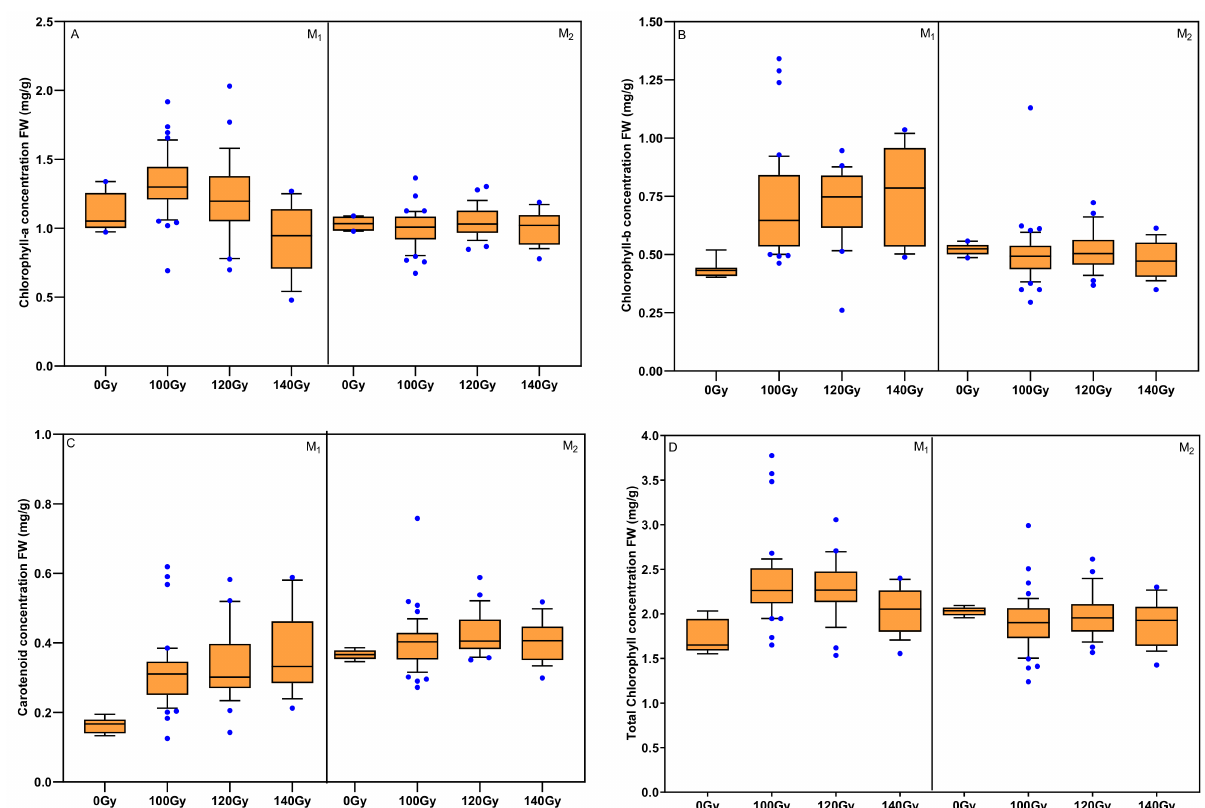
Figure 6. Chlorophyll-a, chlorophyll-b, carotenoid and total chlorophyll concentrations in the M 1 and M 2 generations at different irradiation dosages. ( A ) Chlorophyll-a. ( B ) Chlorophyll-b. ( C ) carotenoid. ( D ) Total chlorophyll